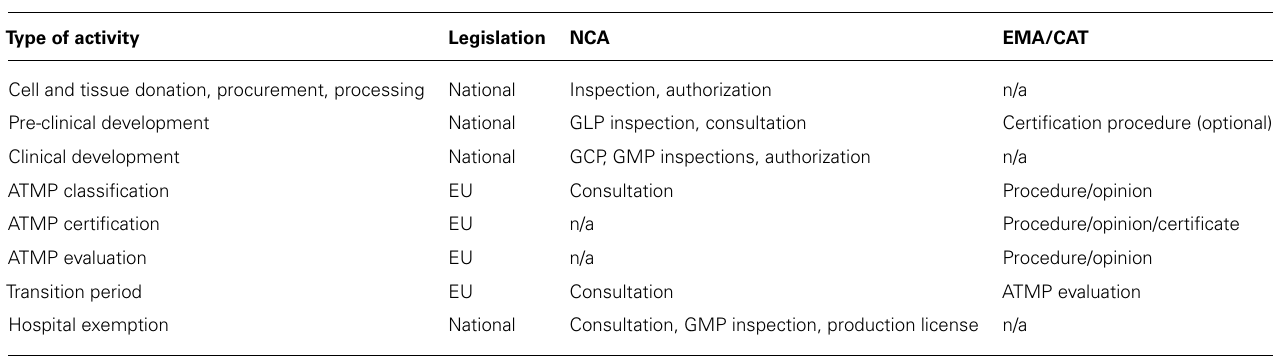
Table 2 | Centralized and national components of the regulatory framework forATMP development in the